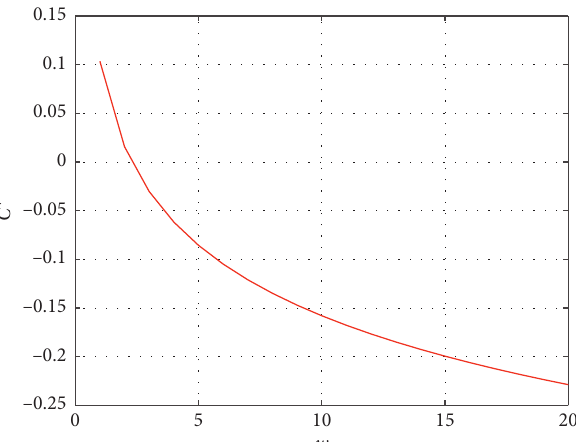
Figure 21: Effect of wholesale price w on the optimal inventory cost C ∗ RMI mode with stochastic demand under in the water supply chain.